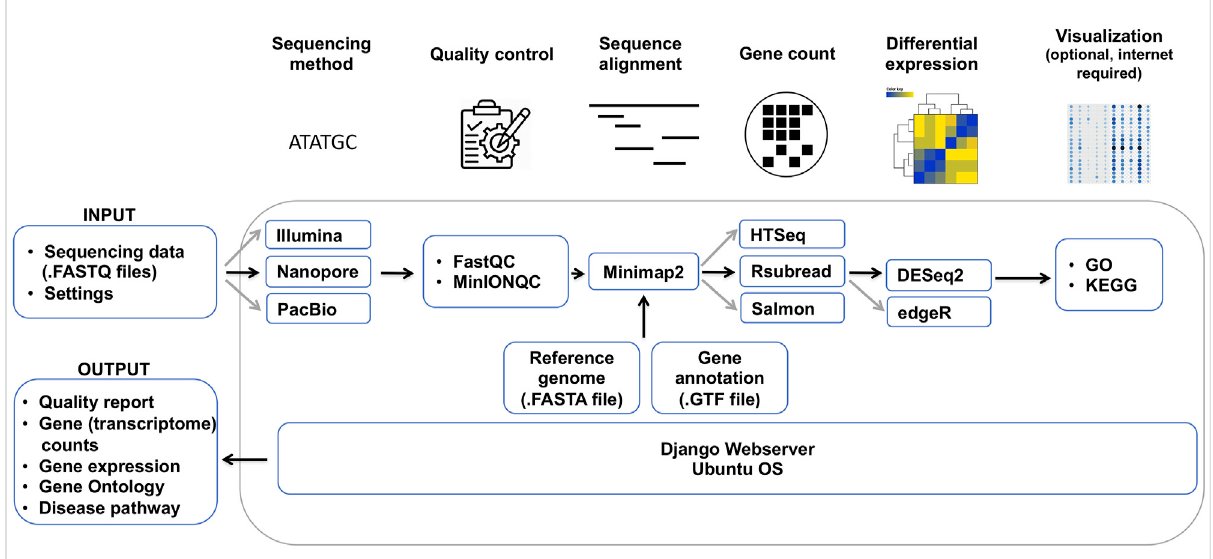
FIGURE 1 BioinformaticaldataanalysispipelineofDuesselpore TM .Depictedaretherequireddata,whichneedtobeprovidedbytheuser,andthedifferent steps of the data analysis, including quality control, sequence alignment, gene count, differential expression and visualization, and the output. Black arrows indicate the main work fl ow optimized for the analysis of ONT data, whereas grey arrows show the variations of the work fl ow that can be selected by the